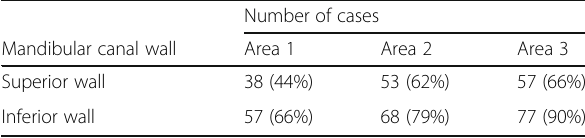
Table 3 Frequency of cases with visibility ratio of 0.7 or more Number of